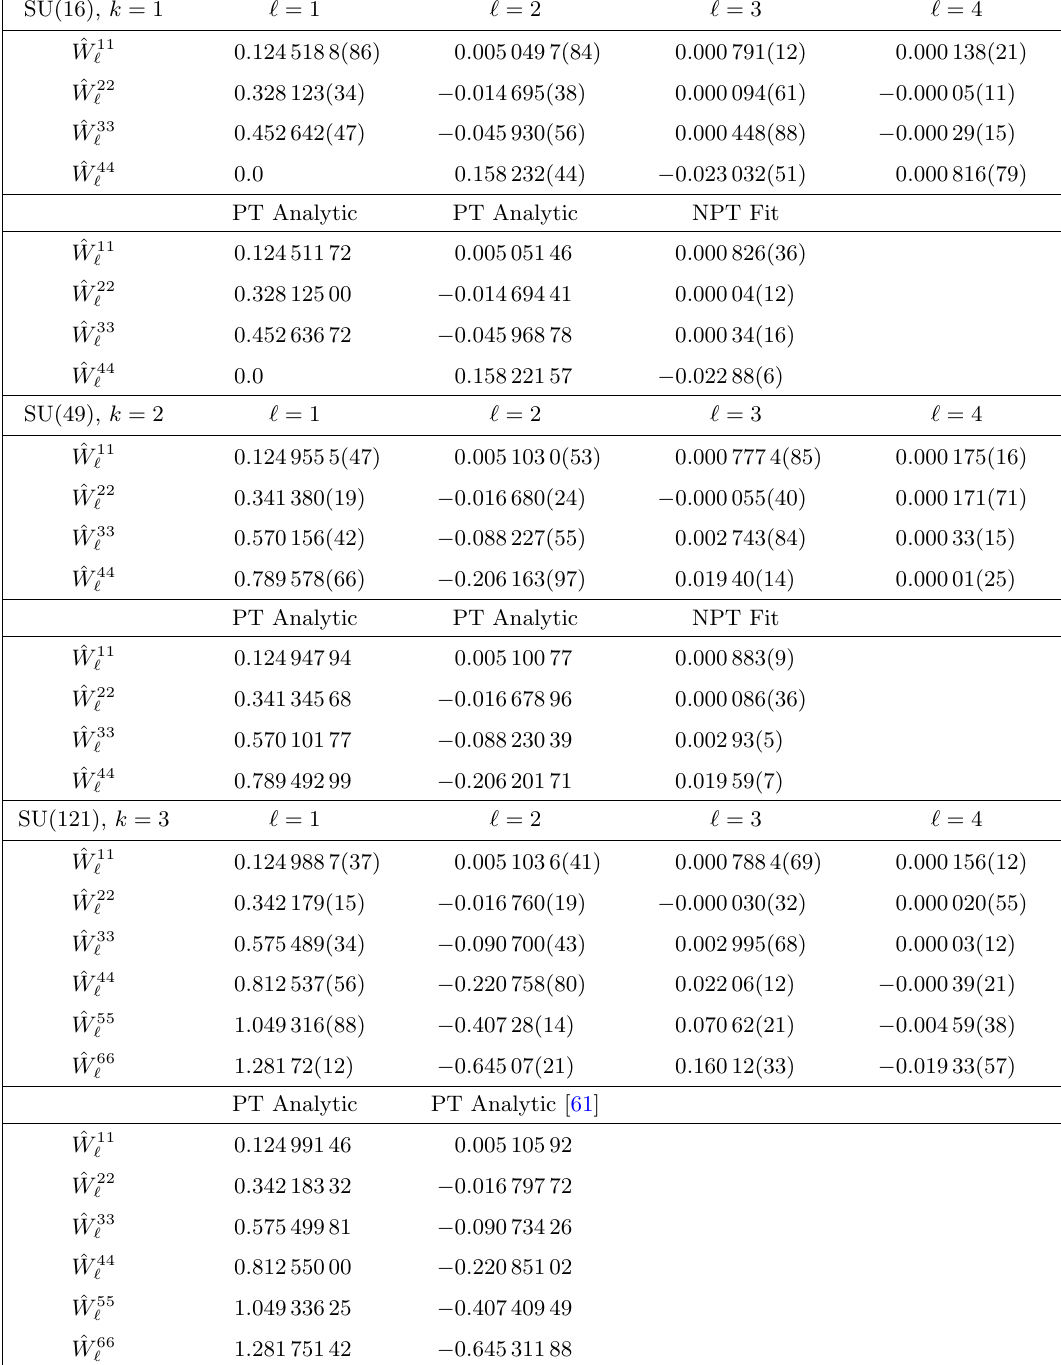
Table 4. Perturbative coe(cid:14)cients for Wilson loops (1 =N MD ! 0 extrapolated). Data in PT Analytic are obtained analytically and data in NPT Fit are obtained by (cid:12)tting the non-perturbative data with a polynomial of (cid:21)